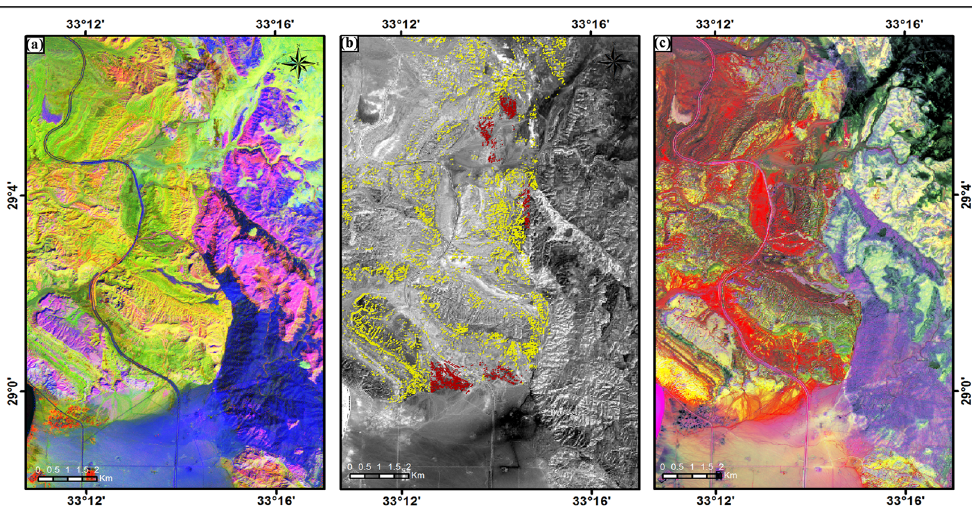
Figure 2. Illustrates ( a ) RGB color composite image of B8/B4, B4/B2, and B11/B12 ratios, ( b ) Kaolinite mineral index based on (B4/B8)*(3 + 4)/11 band ratio (red pixels refer to Matulla Formation and yellow pixels refer to the other clayey geological units), and ( c ) RGB color composite image of PC1, PC2 and PC3 indicates the occurrences of Kaolinite mineral (clay minerals: yellow pixels). These figures were generated from